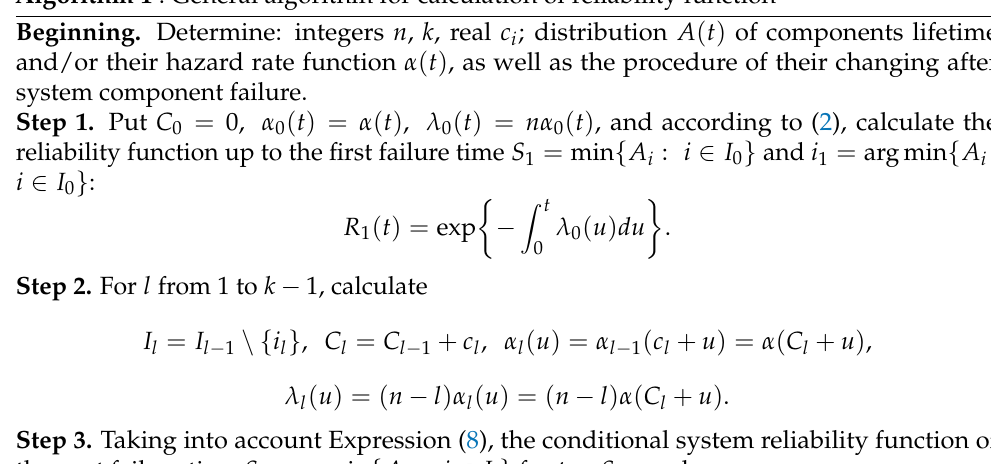
Algorithm 1 : General algorithm for calculation of reliability